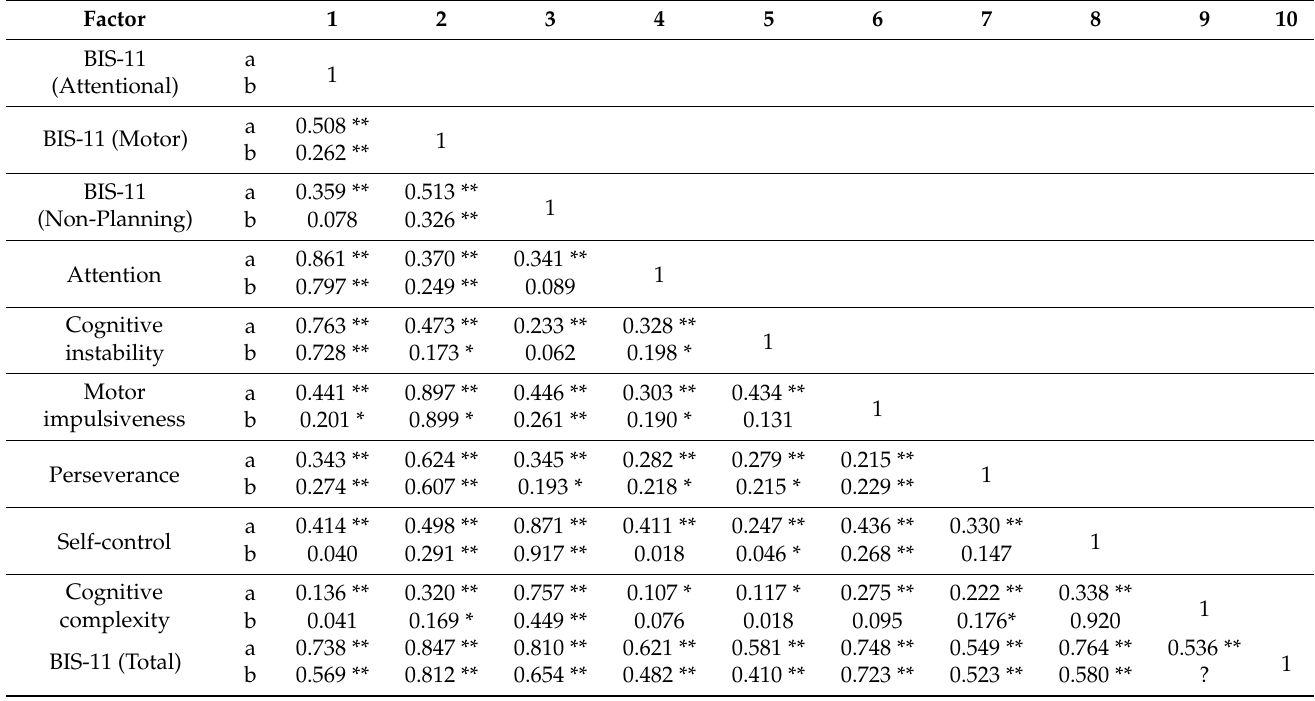
Table 2. BIS-11 symmetric correlation matrix and comparison with a foreign study. Abbreviations: a = own study; b = comparative study. Source: [51], processed by